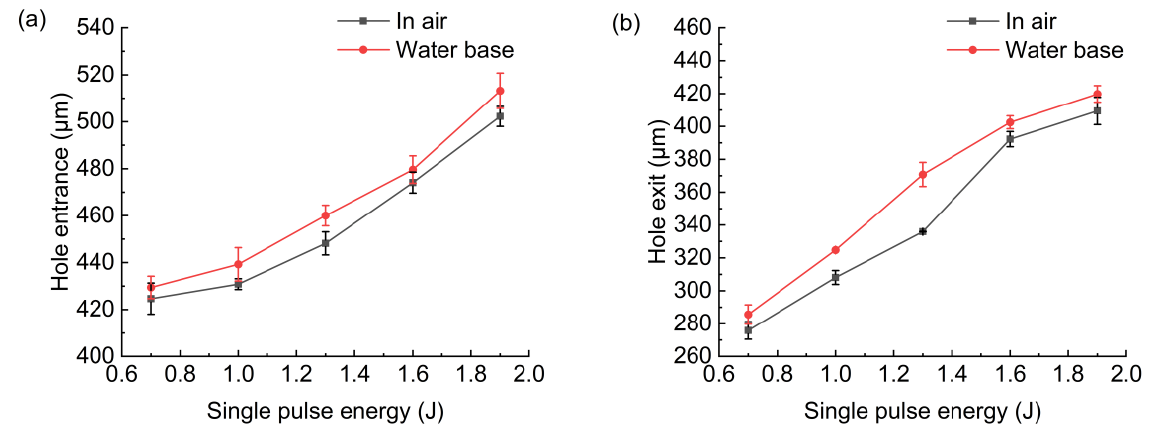
6 of 12 Figure 5. Effect of pulse energy on the morphology of hole entrance and exit: ( a ) in air, ( b ) water- based assistance. Figure 6 shows the effect of pulse energy on the hole entrance and exit diameter. With the increase in pulse energy, the hole entrance and exit diameter increased. The reason was that with the increase in pulse energy, the workpiece would absorb more energy, and the material removal rate would be improved. In the case of water-based assistance, the hole entrance and exit diameter were slightly larger than that in the case of air. If the workpiece was drilled through, the water entered into the hole from the hole exit; then, the water would be heated and evaporated to steam under the action of the laser. The steam mixed with water droplets generated impact force, which promoted the removal of